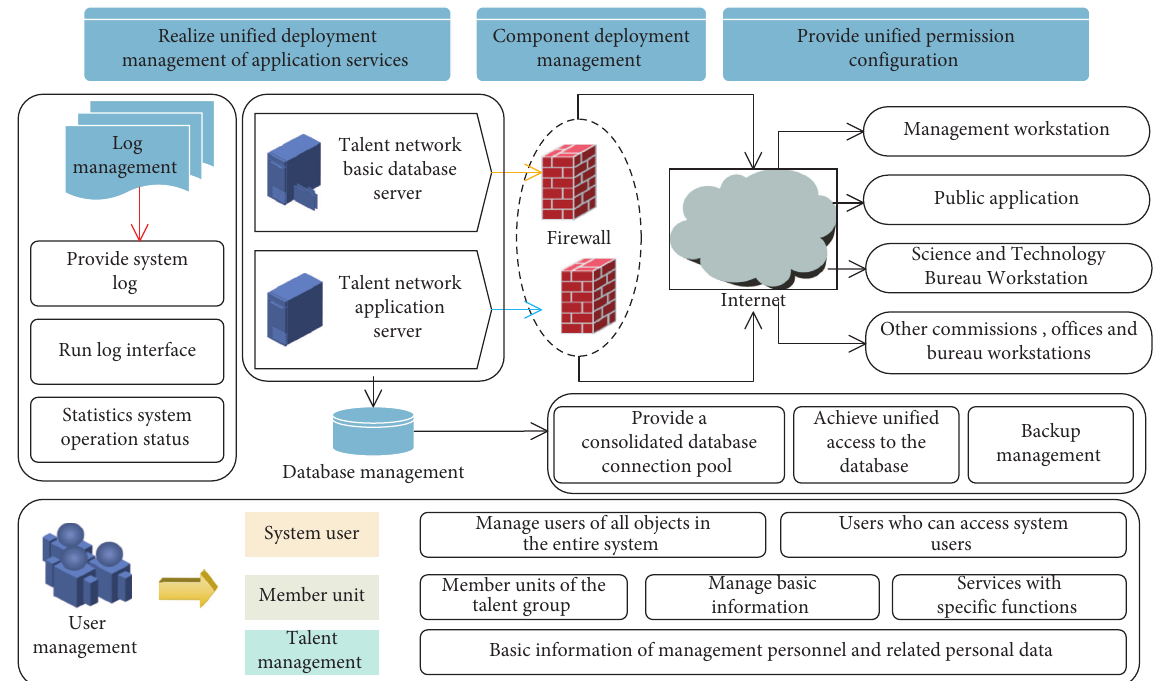
Figure 1: Structural diagram of talent life cycle management platform system